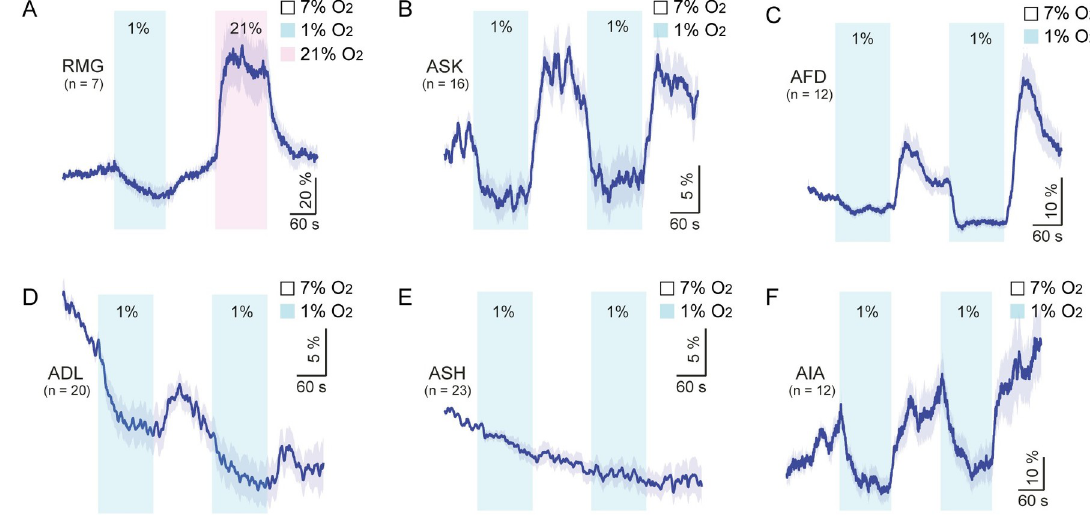
Fig 7. Hypoxia-evoked Ca 2+ responses in different neurons. (A) Ca 2+ responses evoked by 1% and 21% O 2 in RMG interneurons. Ca 2 + responses were measured using YC2.60. (B–F) Hypoxia-evoked Ca 2+ responses in the ASK, AFD, ADL, and ASH sensory neurons, and in the AIA interneurons. Ca 2+ responses were measured using YC3.60 sensors in these neurons. The source code underlying calcium imaging analysis can be found at https://github.com/neuronanalyser/neuronanalyser. O 2 , oxygen.